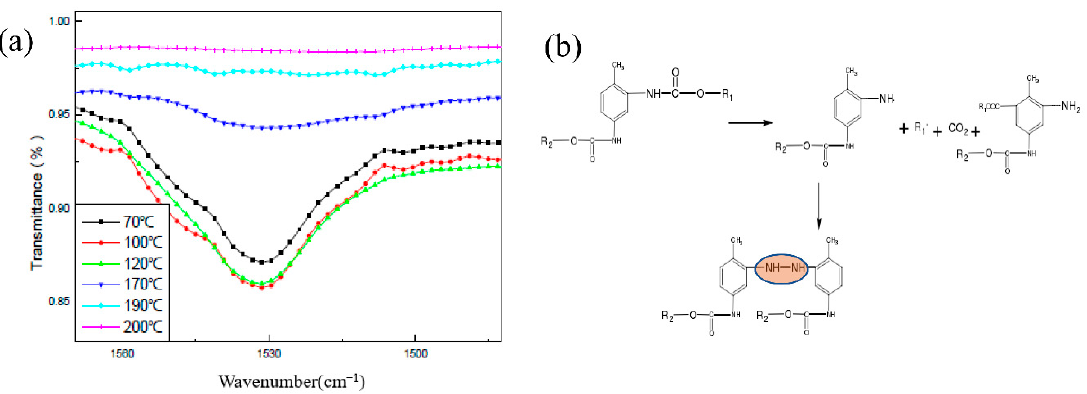
Figure 8. ( a ) Variation trend of N–H relative absorbance and ( b ) decomposition reaction process.